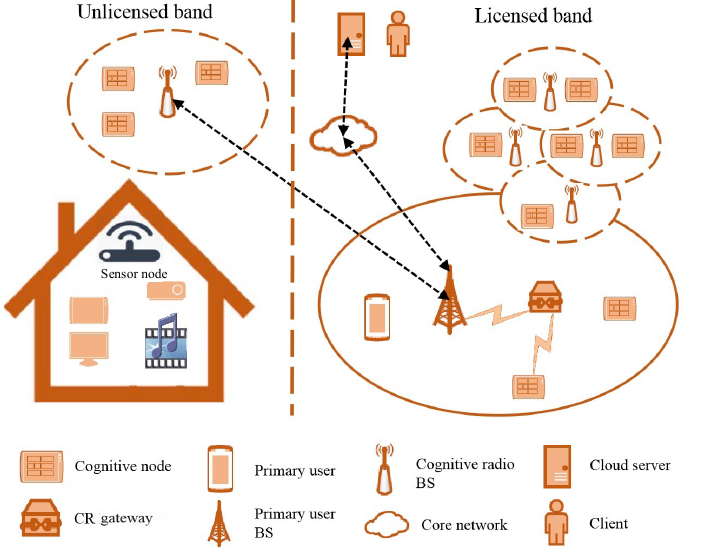
Figure 2. Communication architecture for a cognitive radio